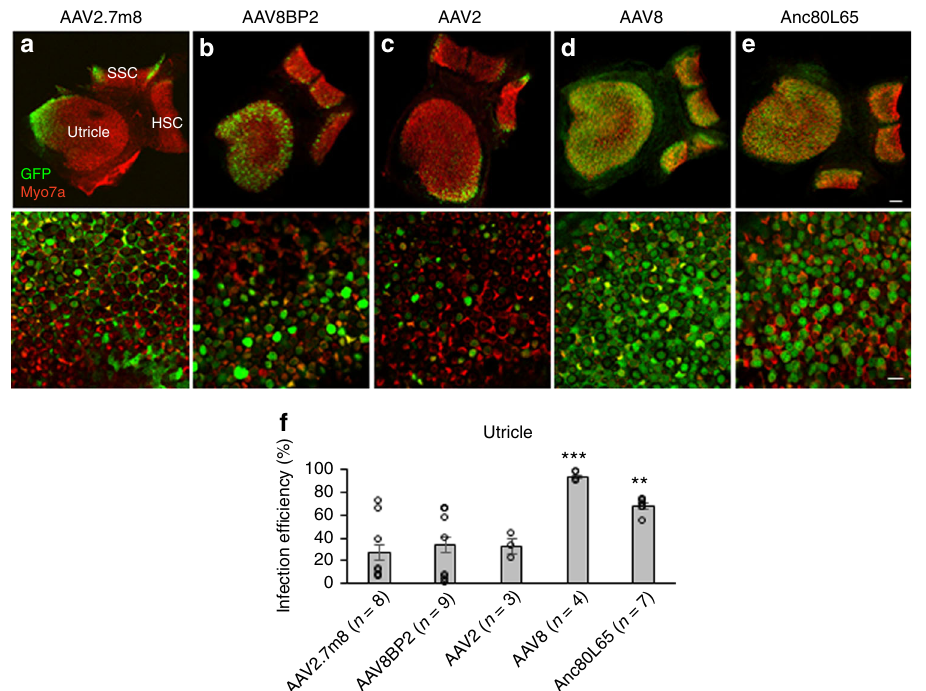
Fig. 3 AAV2.7m8 infects vestibular hair cells with lower ef fi ciency. a – e 10 × and 40 × images of utricles showing the hair cell infection ef fi ciency in response to posterior canal AAV delivery. AAV2.7m8-GFP ( a ), AAV8BP2-GFP ( b ), AAV2-GFP ( c ) infected utricular hair cells at lower levels. In contrast, AAV8-GFP ( d ) and Anc80L65-GFP ( e ) infected utricular hair cells at higher levels. GFP expression is shown in green and Myo7a expression (a marker for hair cells) is shown in red. Scale bar represents 50 μ m for 10 × and 100 μ m for 40 × images. f Quanti fi cation of utricular hair cell infection ef fi ciency. Statistical signi fi cance with reference to AAV2.7m8 is shown above error bars (* represents p < 0.05, ** represents p < 0.01, and *** represents p < 0.001; t -test). Error bars represent standard errors. Open circles represent the average infection ef fi ciency of each animal. n represents the number of animals tested. For each animal, hair cell infection was quanti fi ed at two different locations in each utricle. Source data are provided as a Source Data fi le. SSC, superior semicircular canal; HSC, horizontal semicircular canal. p, p